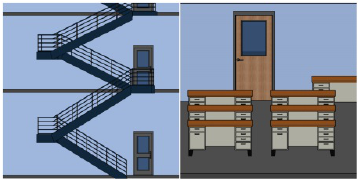
Figure 2: Model enrichment with components in BIM